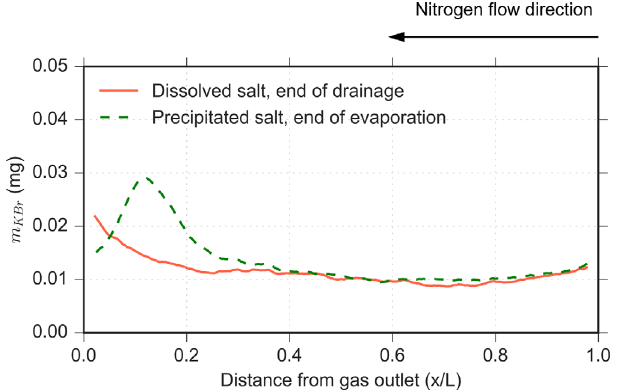
Fig. 7. Salt distribution, dissolved in the brine at Swi (plain curve) and precipitated at the end of the dry-out (dashed curve). The mass of salt is given for a pixel volume of 6.67 (cid:1) 10 (cid:3) 4 cc.